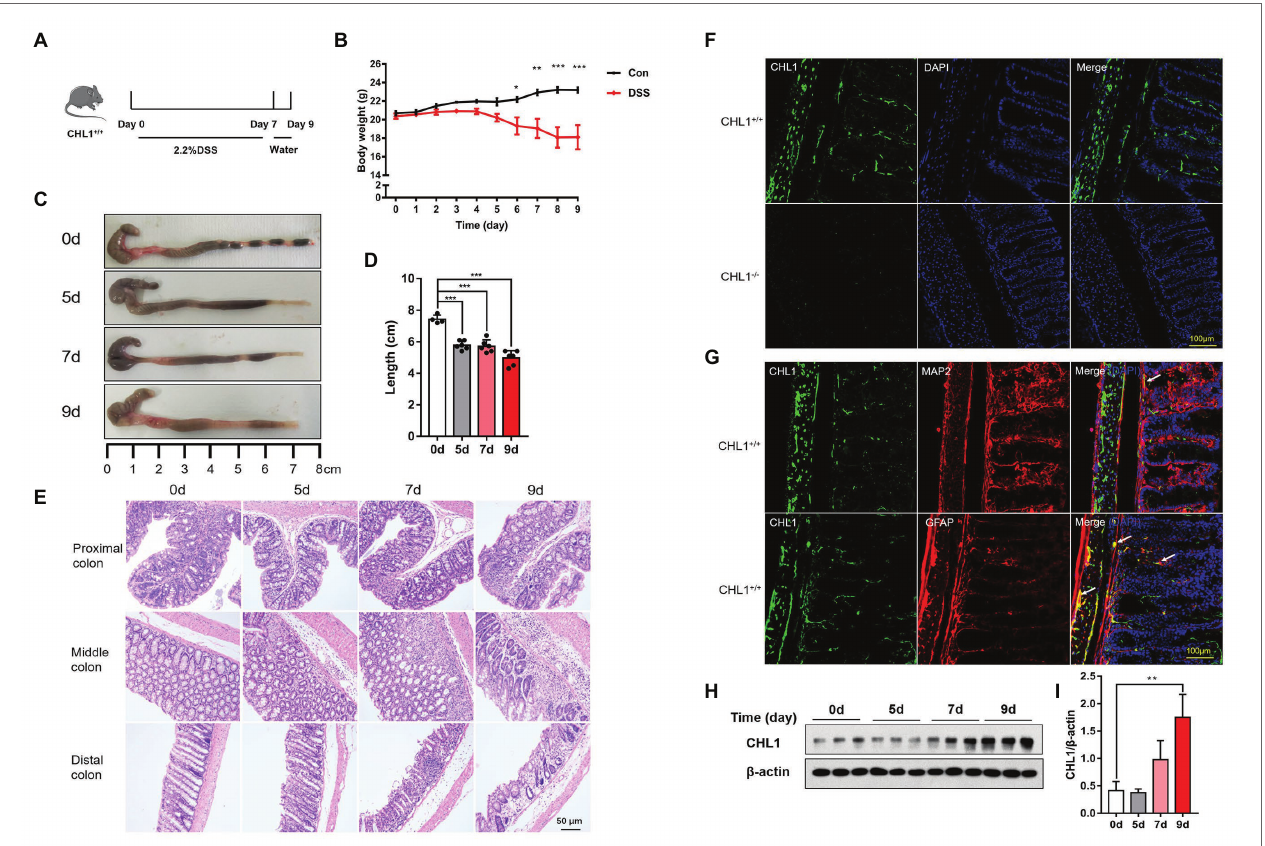
FIGURE 1 | CHL1 expression was increased in dextran sulfate sodium (DSS)-induced colitis. (A) DSS-induced acute colitis mouse model. CHL1 +/+ mice had ad libitum access to sterile drinking water containing 2.2% DSS for 7 days, followed by normal drinking water for 2 days. The mice were euthanized on the 5th, 7th, and 9th days after the initiation of DSS treatment. (B) Body weight loss in the DSS-induced acute colitis mouse model (* p < 0.05, ** p < 0.01, *** p < 0.001, n = 4–6/ group). (C,D) Colon sections obtained from mice were analyzed for their outward appearance; time-dependent effects of DSS treatment on colon length (*** p < 0.001; n = 4–6/group). (E) Time-dependent effects of DSS treatment on representative histological images of colonic tissue collected from CHL1 +/+ mice. (F) CHL1 (green) expression was detected in the colonic tissue of CHL1 +/+ mice, while CHL1 was totally negative in the colon from CHL1 −/− mice by using an immunofluorescence assay. (G) Representative immunofluorescent images indicate that CHL1 (green) is co-localized with microtubule-associated protein 2 (MAP2; red) and glial fibrillary acidic protein (GFAP; red) in mouse colonic sections. (H,I) Western blots (H) and analysis (I) showing the time-dependent effects of DSS treatment on CHL1 expression in the colon tissue of CHL1 +/+ mice (** p < 0.01, n =